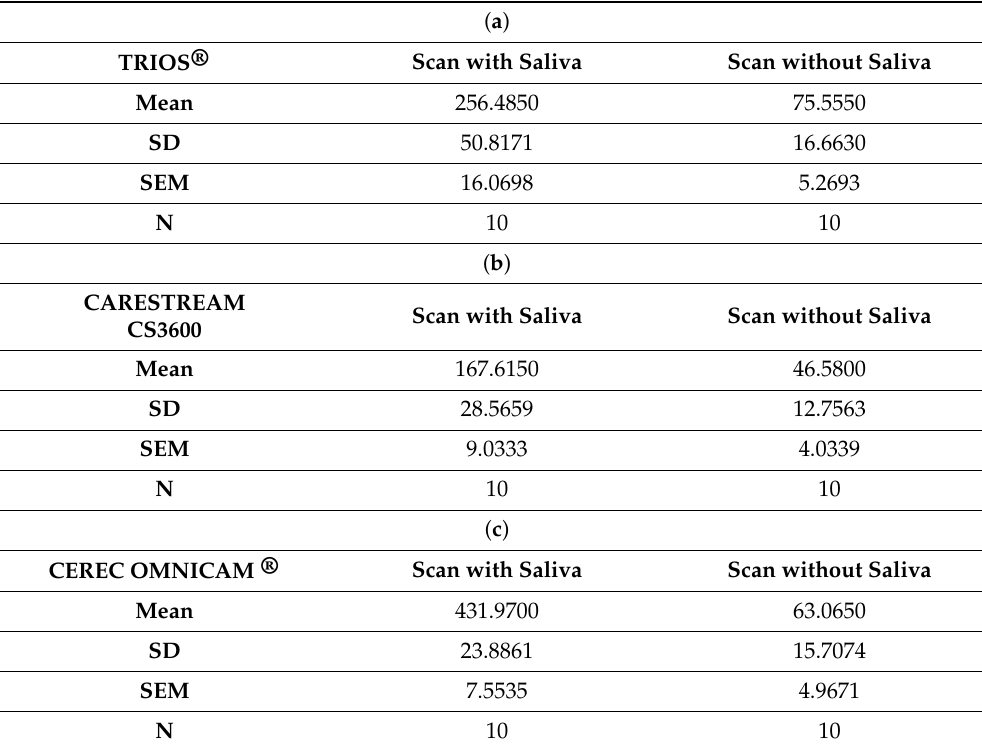
Table 12. t -test sample 3.